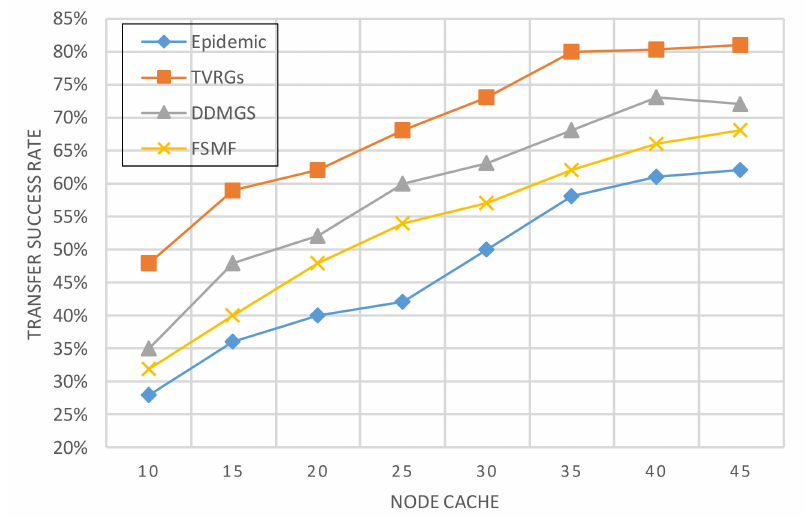
Figure 11. The relationship between node cache and transfer success rate. The relationship between the average maximum transmission distance between nodes and the average delay is given in Figure 12. From the current findings, it is clear that nodes can increase the probability of encountering message relay nodes and target